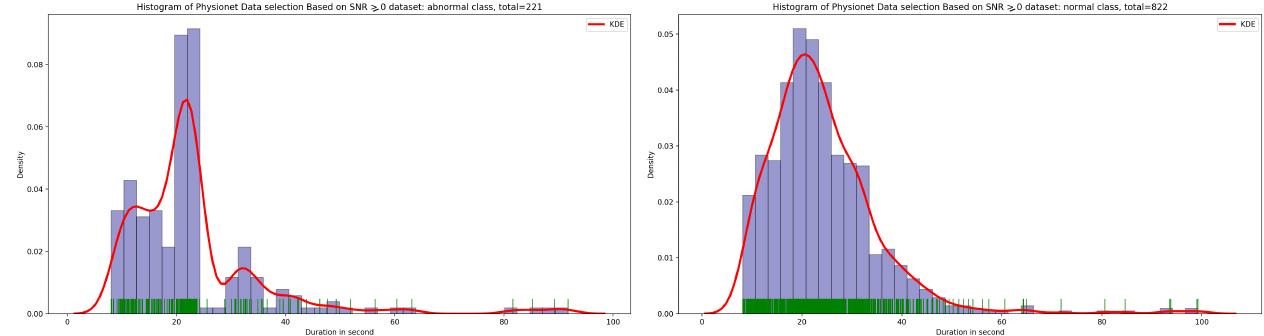
Figure 8. PCG sample distribution in function of duration after SNR greater than or equal to 0 in data selection process.